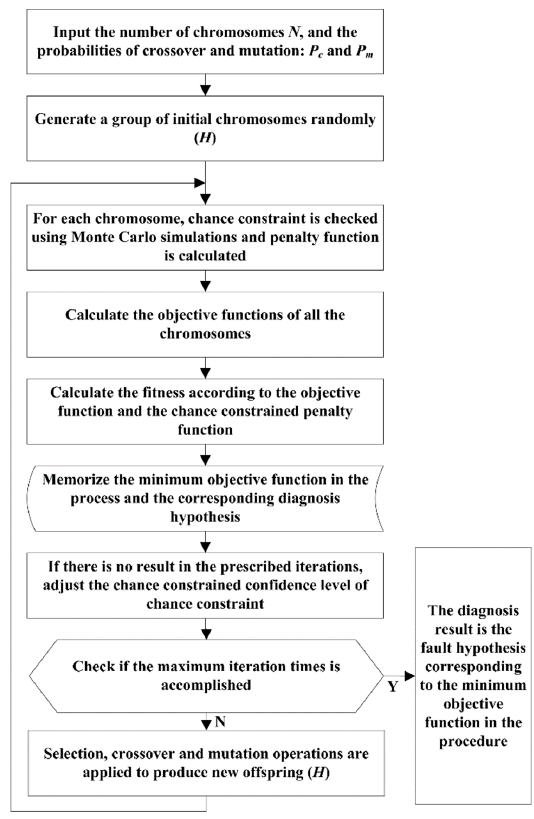
Figure 3. The flowchart of the solving procedure.